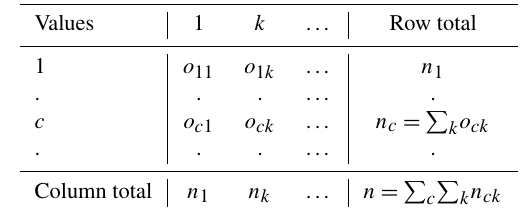
Table 3. Coincident matrix. The coincident matrix is built by count- ing the frequencies of ck pairs occurring in the reliability data ma- trix (Table 2).